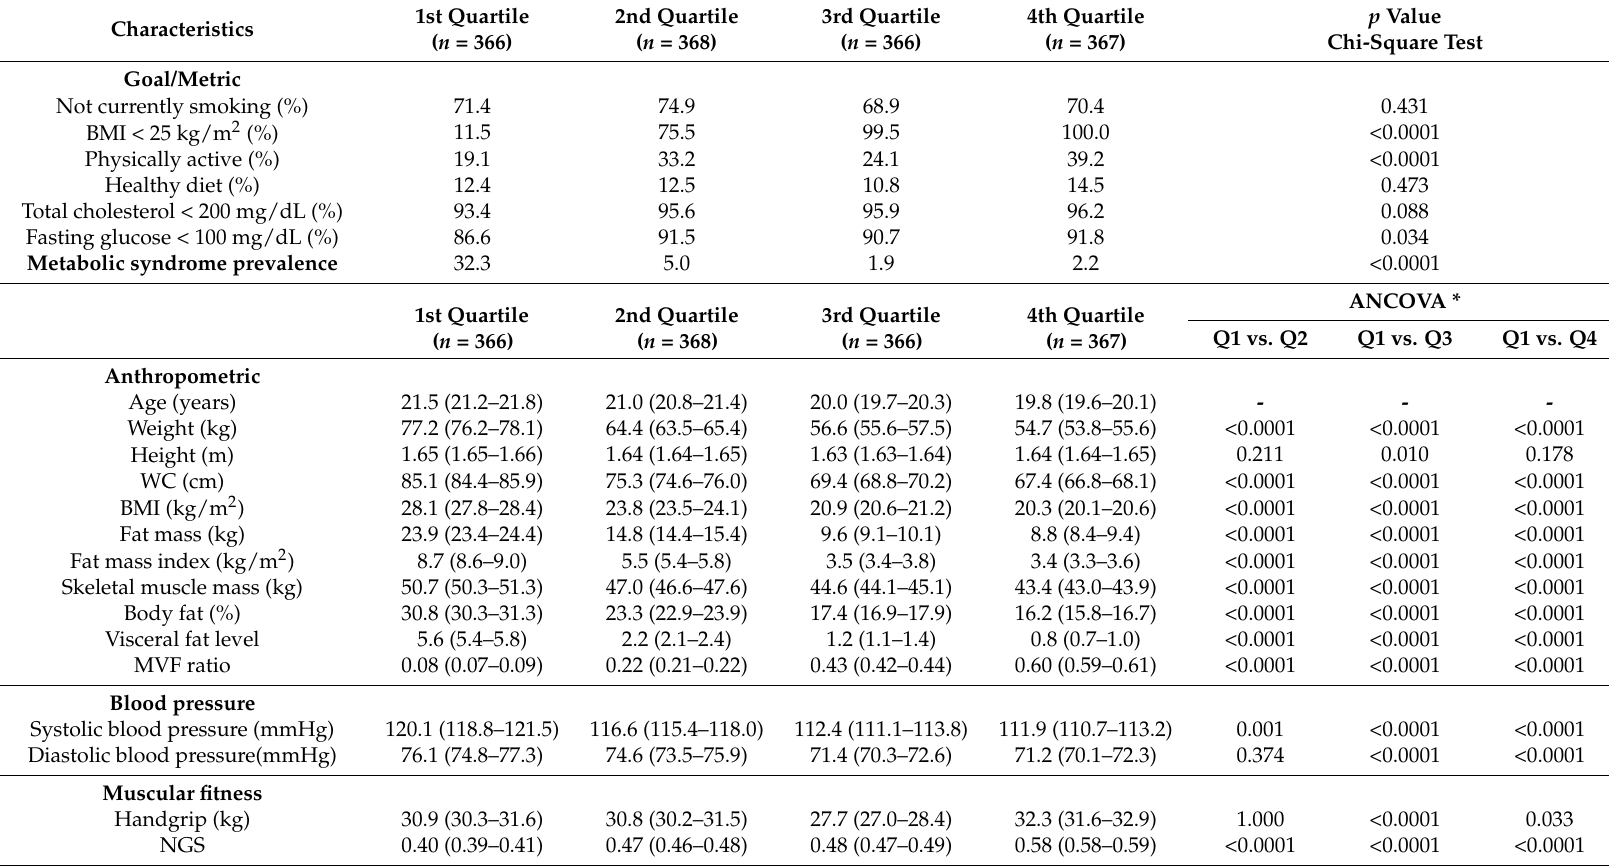
Table 1. The prevalence rates of the number of cardiovascular health (CVH) metrics, metabolic syndrome (MetS), anthropometric characteristics, blood pressure, and muscular fitness parameters for 1467 study subjects with quartile stratification according to the muscle fitness to visceral fat (MVF) ratio.